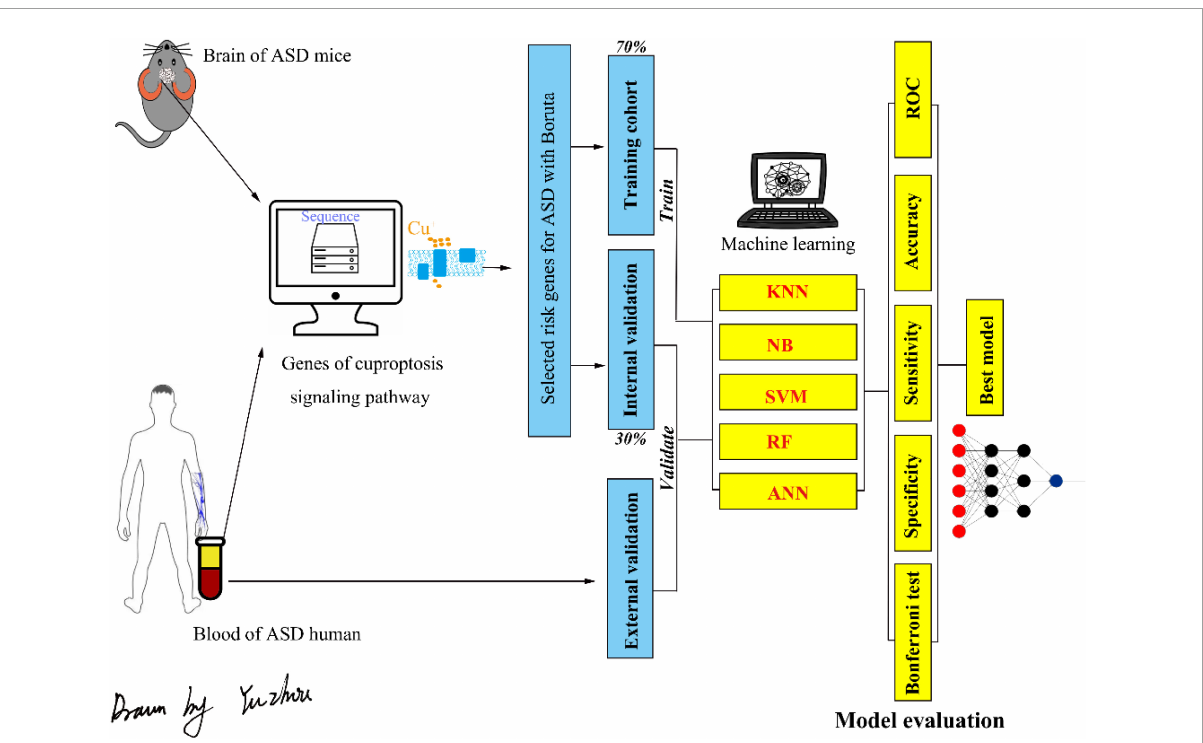
FIGURE1 The flowchart of the present study. ASD, autism spectrum disorder; KNN, k-nearest neighbor; NB, naive Bayesian; SVM, support vector machine; RF, random forest; ANN, artificial neural